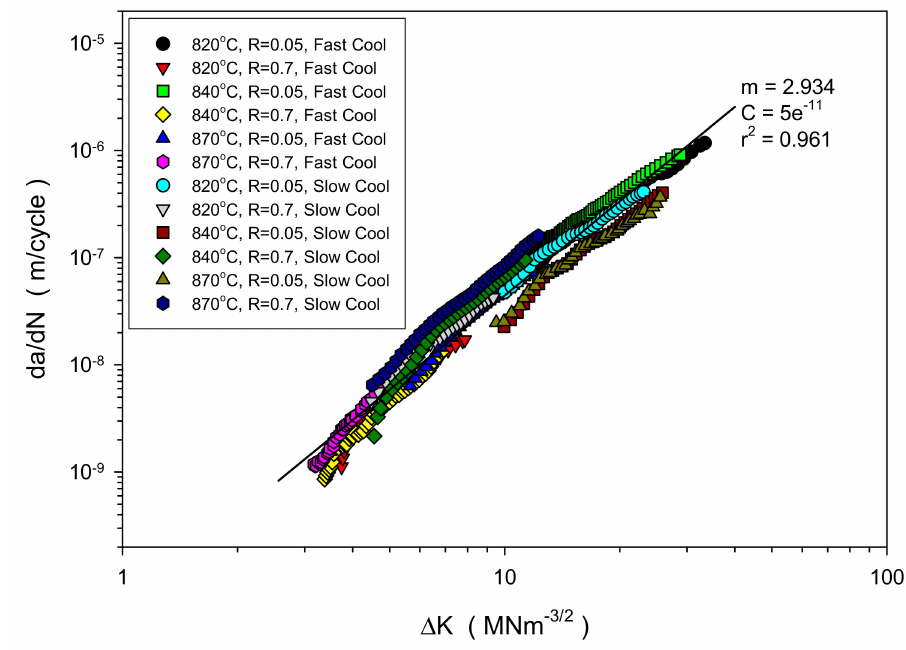
Figure 10. Combined fatigue crack growth data for Ti-407, representing six di ff erent microstructures and two R